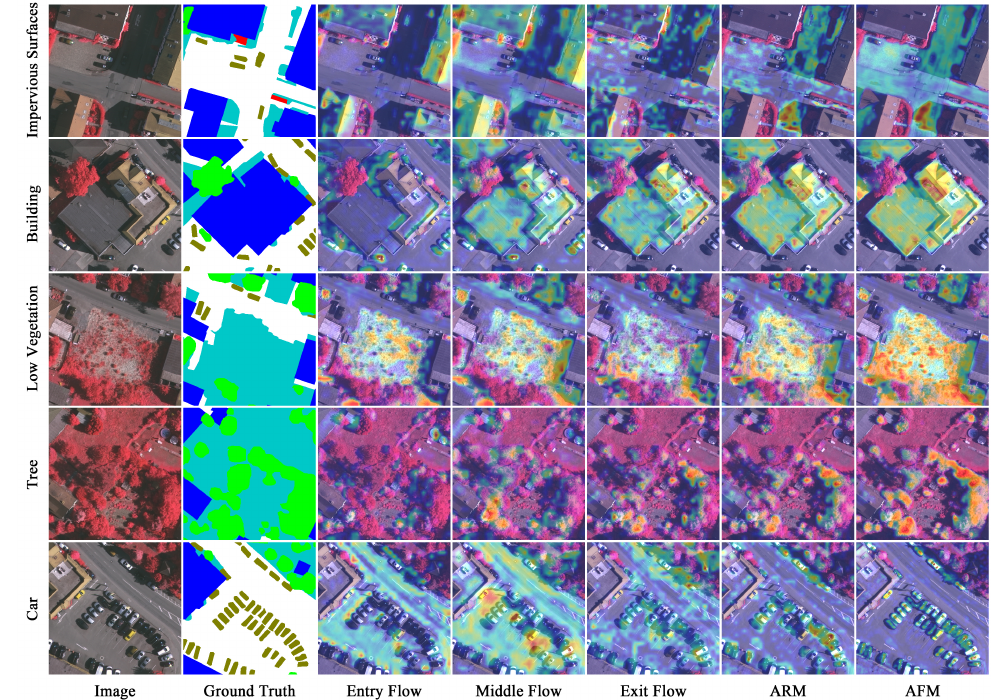
Figure 15. Visualization analysis of XANet on the Vaihingen dataset.